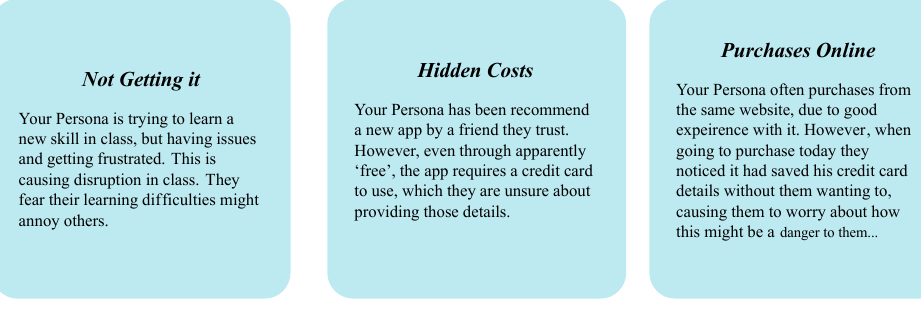
Figure 4. Scenario descriptions.